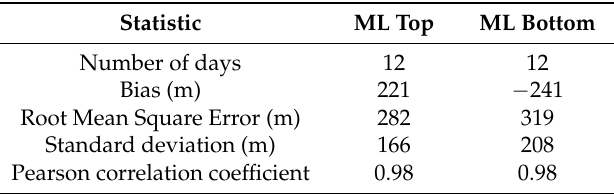
Table 2. Performance of melting layer (ML) identification from ARMOR range-height indicator (RHI) scans relative to the University of Alabama in Huntsville X-band Doppler Profiling Radar (XPR) estimates of the ML. Statistic ML Top ML Bottom Number of days 12 Bias